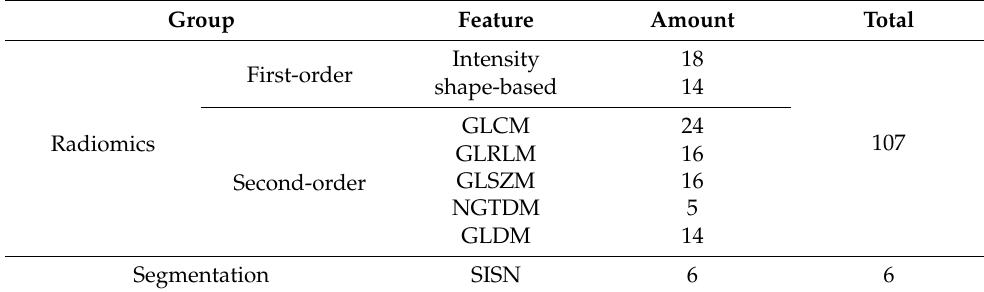
Table 2. Amount of each feature type that was